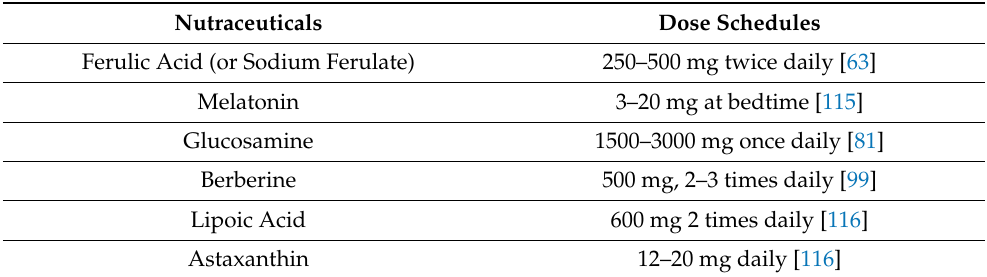
Table 1. Suggested dose schedules for nutraceuticals with potential for controlling dry